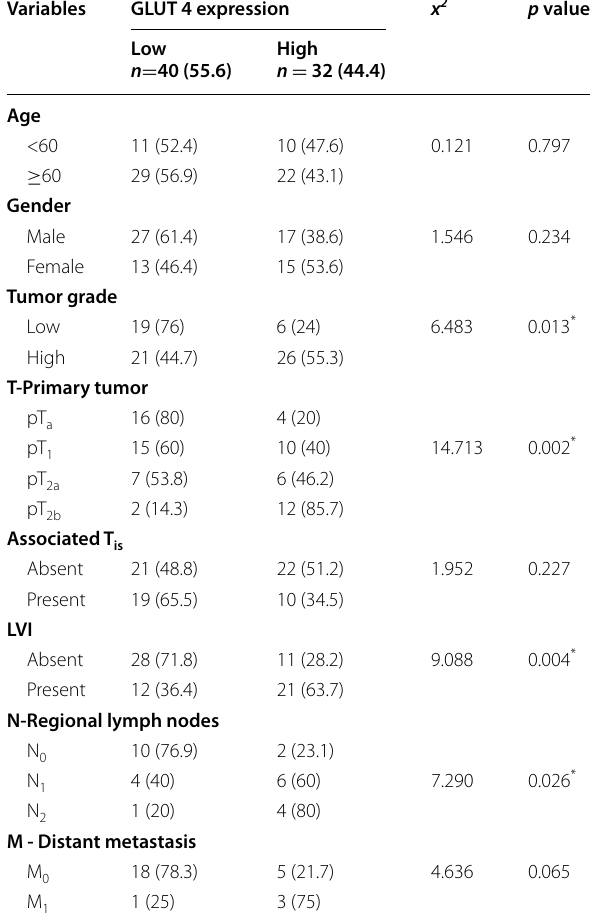
Table 1 Clinicopathological characteristics of studied cases Variables